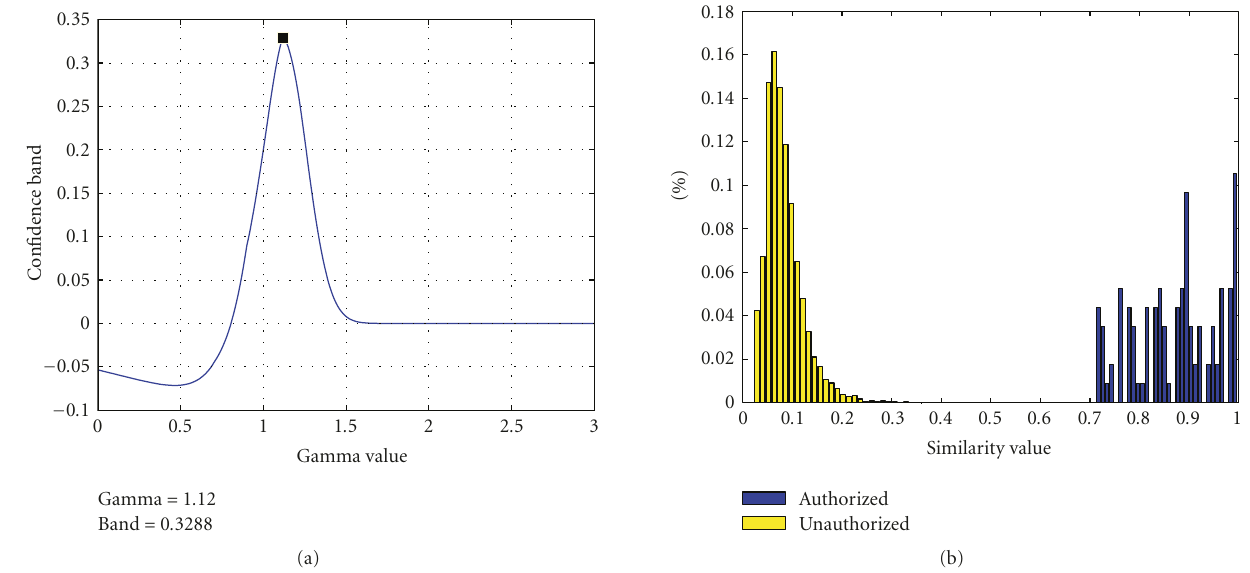
Figure 15: (a) Confidence band size versus gamma ( γ ) parameter value. Maximum band is obtained at γ = 1 . 12. (b) Similarity values distributions using the normalised metric with γ = 1.12.